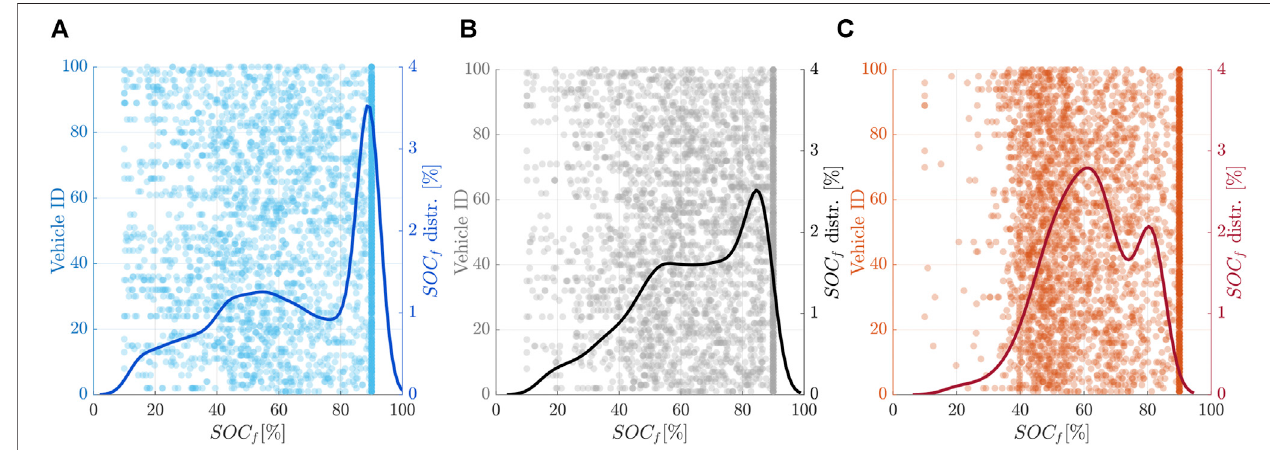
FIGURE 10 | 31-day SOC f distribution applying the standard CMS (A) , the 1d-OCMS (B) , and the 2d-OCMS (B) . The right axis shows the average estimated distribution (solid lines). The left axis refers to the scatter plot of the SOC fi (100 users) collected during the 31-day simulation.